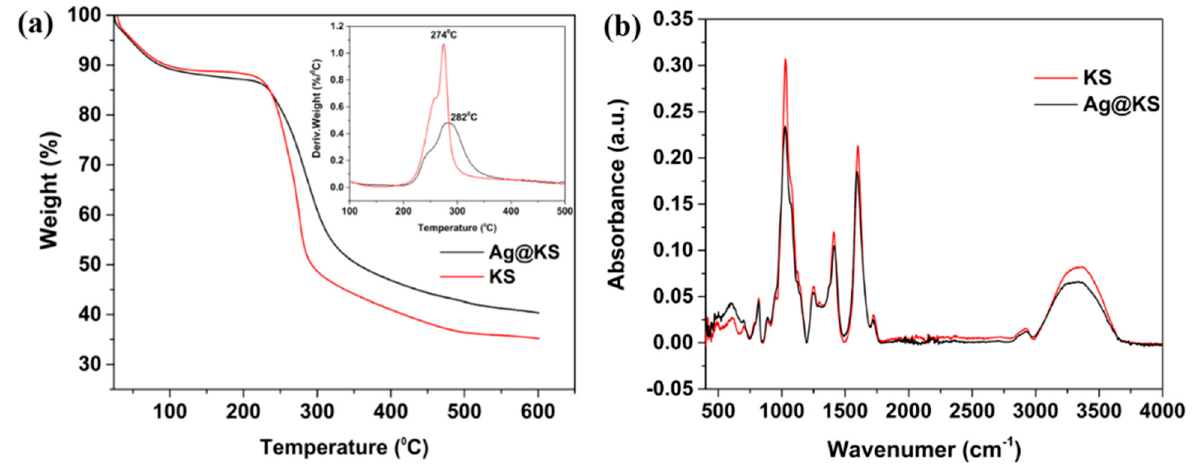
Figure 3. ( a ) Thermogravimetric profile of KS and Ag@KS sponge (derivative curve is inserted), ( b ) FTIR spectra of KS and Ag@KS sponge.